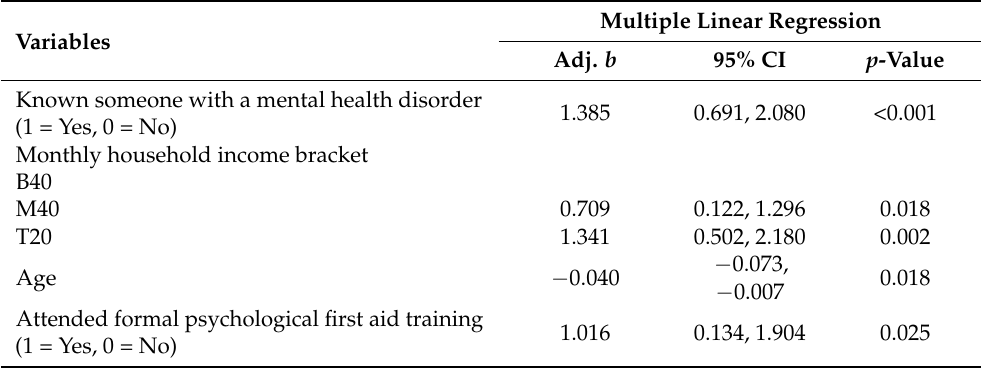
Table 4. Multiple linear regression of mean score of MAKS-M among parents, guardians, and teachers of adolescents in West Malaysia (n =